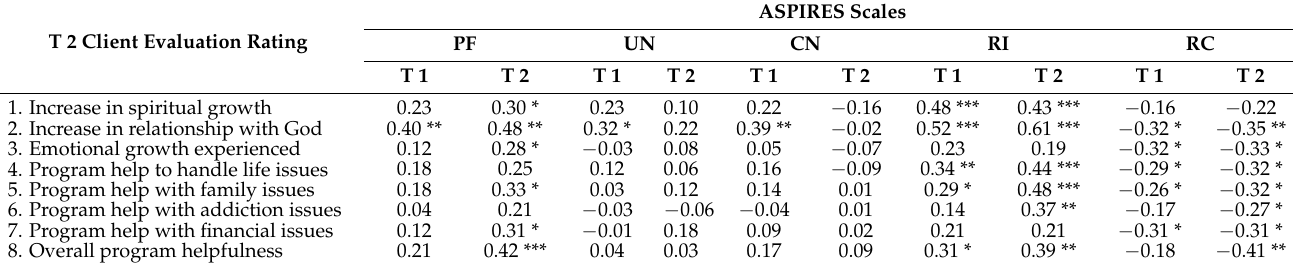
Table 5. Correlations between ASPIRES Scores at Time 1 and Time 2 with Time 2 Client Ratings of Treatment. T 2 Client Evaluation